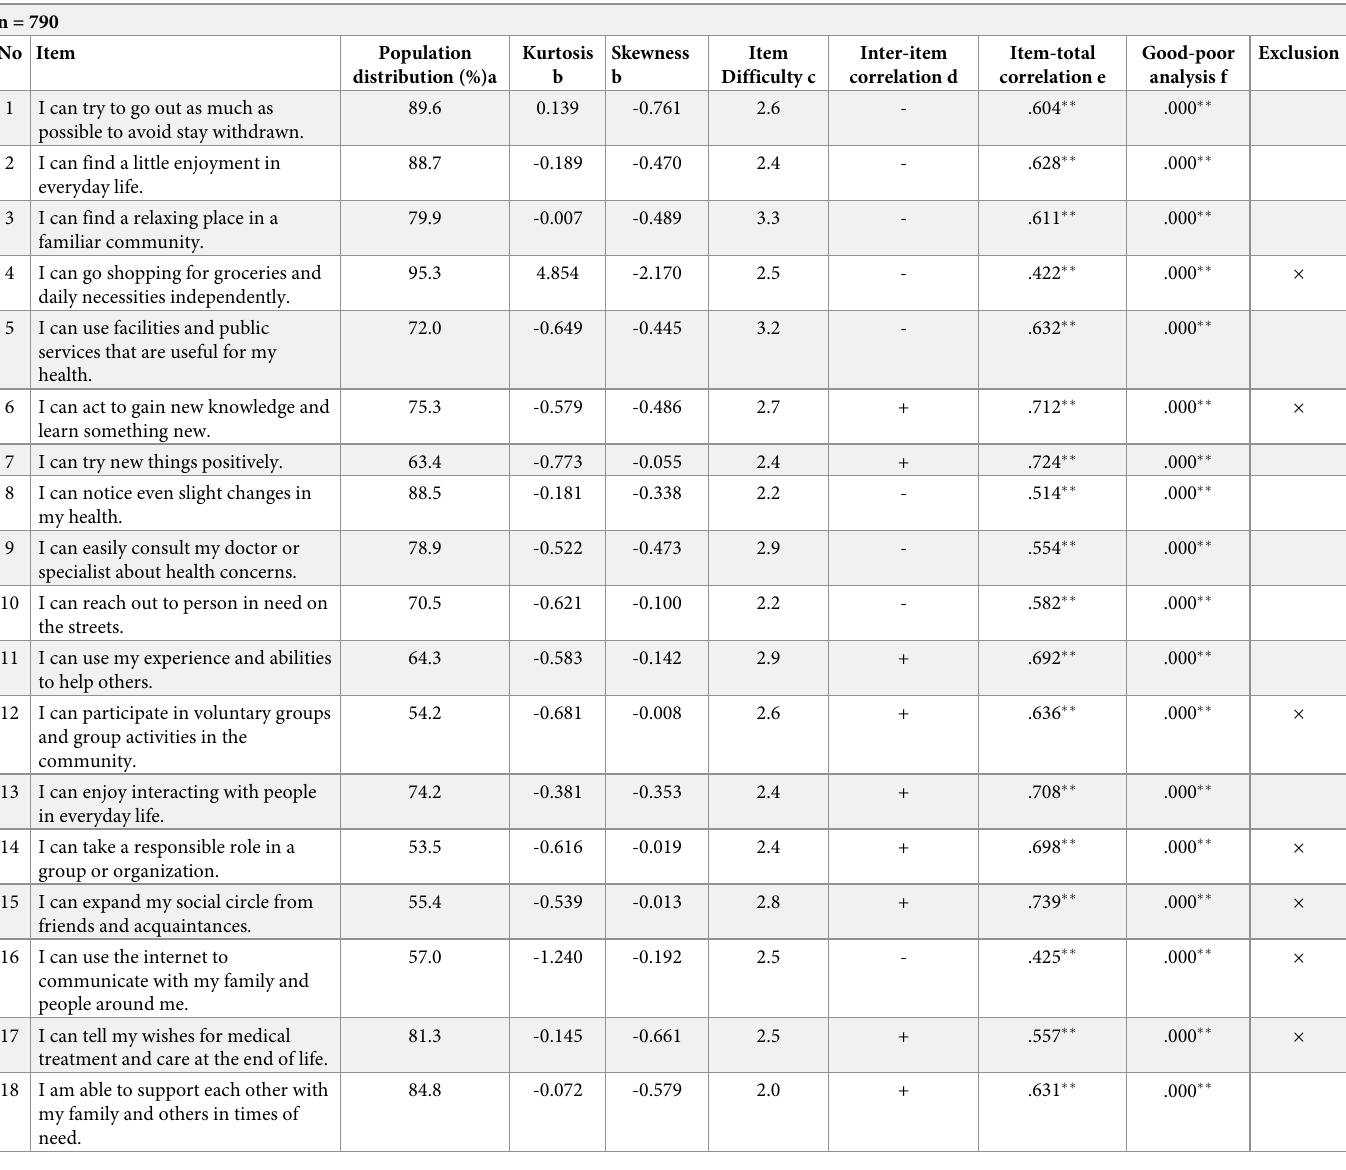
Table 2. Item analysis of the “social contact self-efficacy scale for third agers”. n =